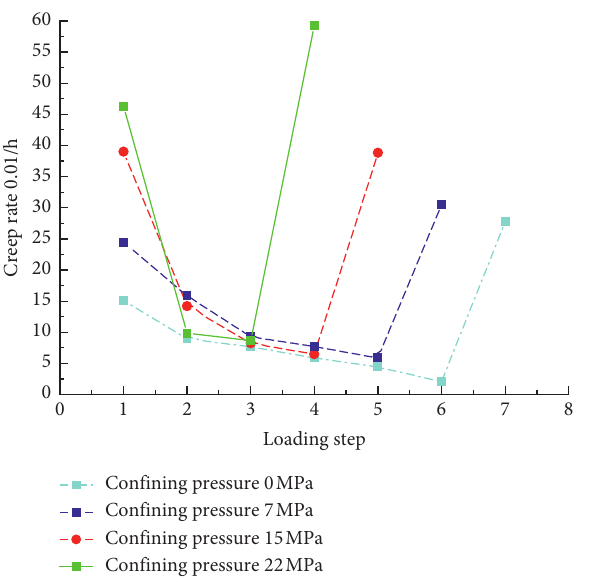
Figure 5: Change trend of initial creep rate of rock-concrete composite specimens with different confining pressures under step loading.